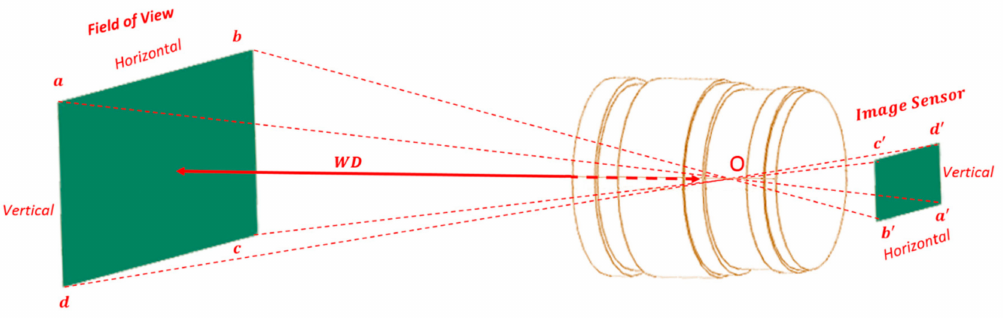
Figure 5. Principle of industrial camera